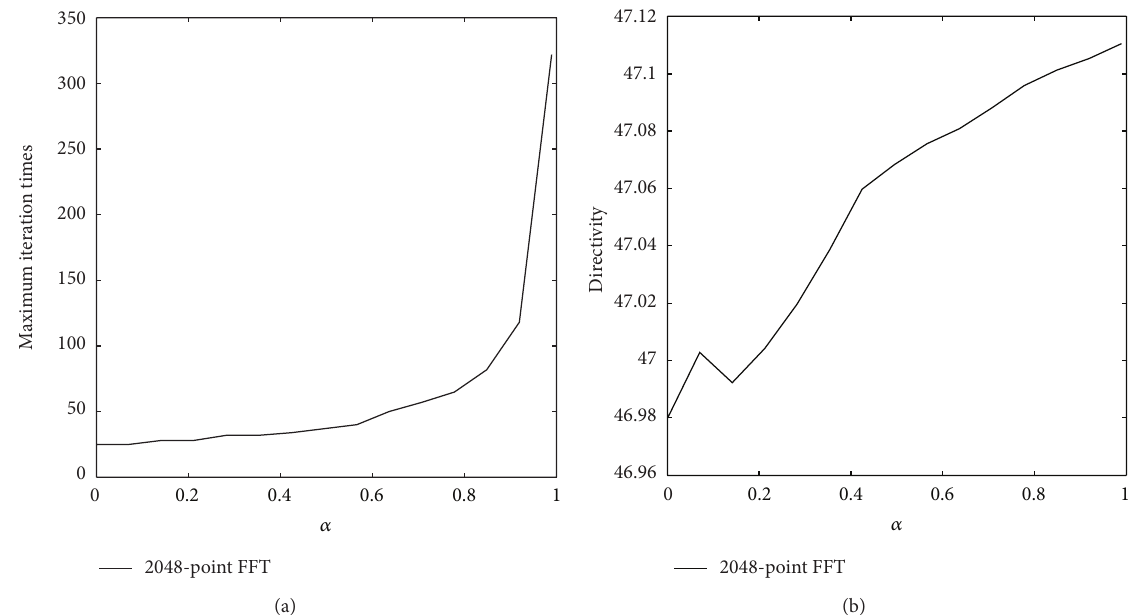
Figure 5: Maximum iteration times (a) and directivity of the array (b) versus 𝛼 for the amplitude-only tapering.